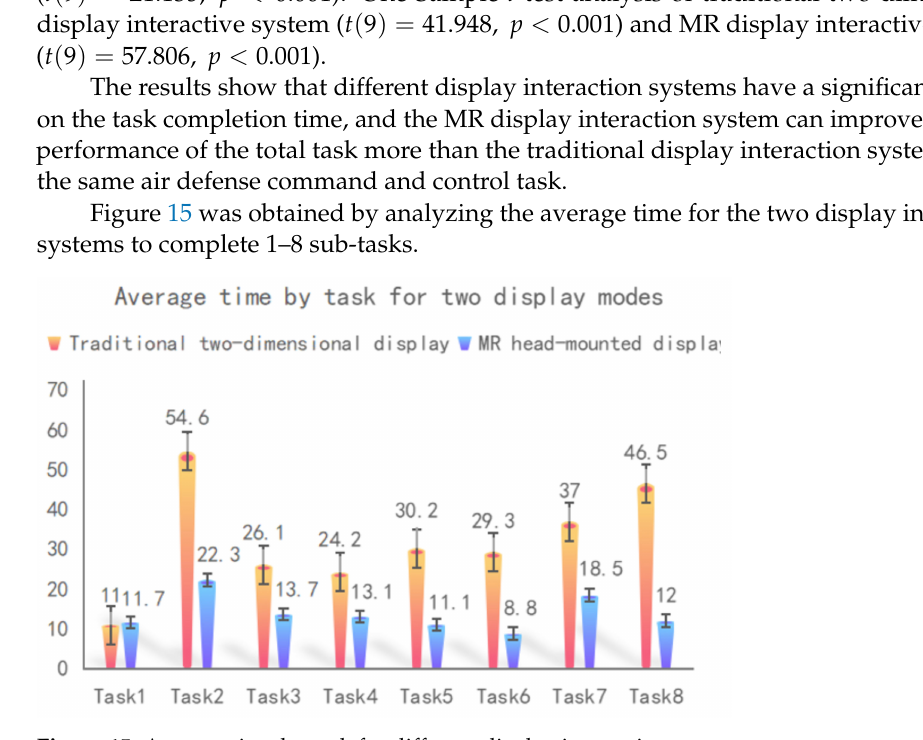
Figure 15. Average time by task for different display interactive